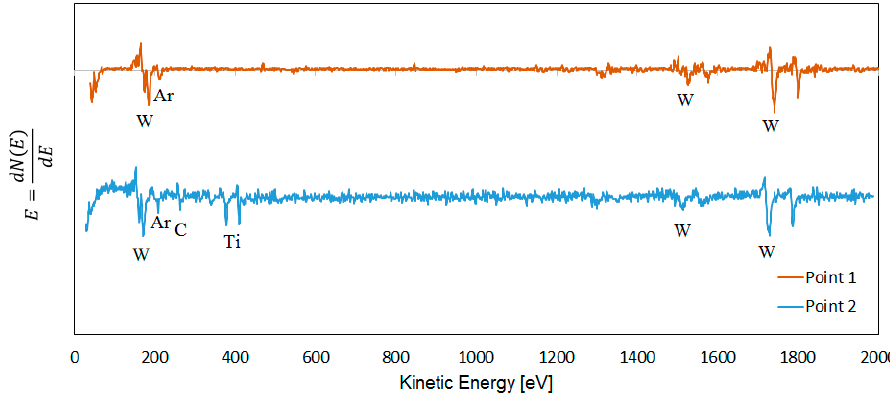
Figure 12. AES survey spectra obtained after 5 s sputtering in a point in the center of the diffusion layer (point 1) and in a point in the diffusion layer close to adhered work material (point 2). Note the presence of Ti (TiC) in point 2.